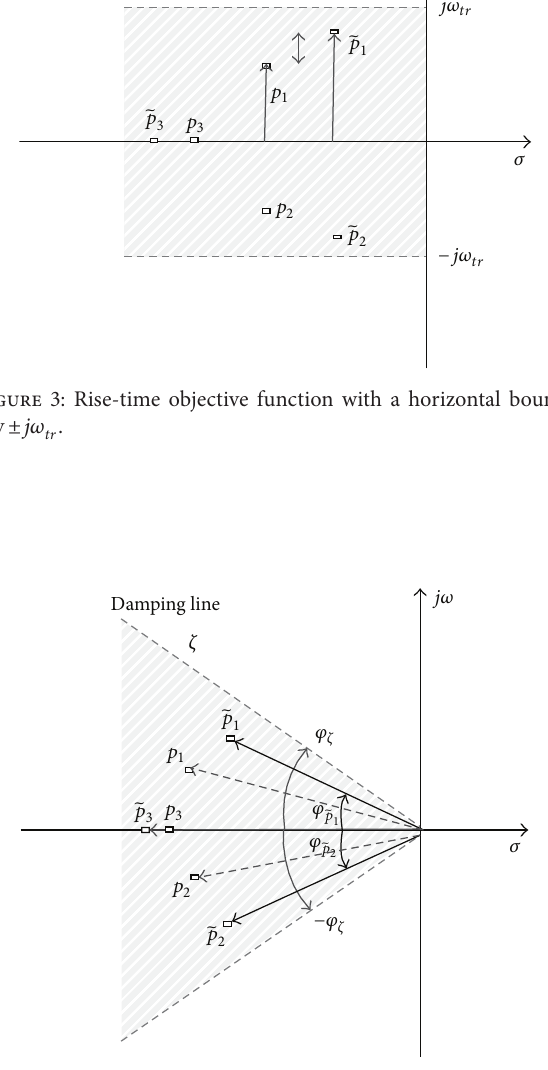
Figure 4: Damping-ratio objective function with parameter ±𝜑 𝜁